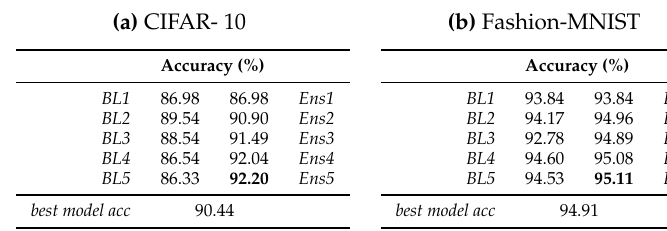
Table 14. Ensemble of models with different architectures and incorporated regularization